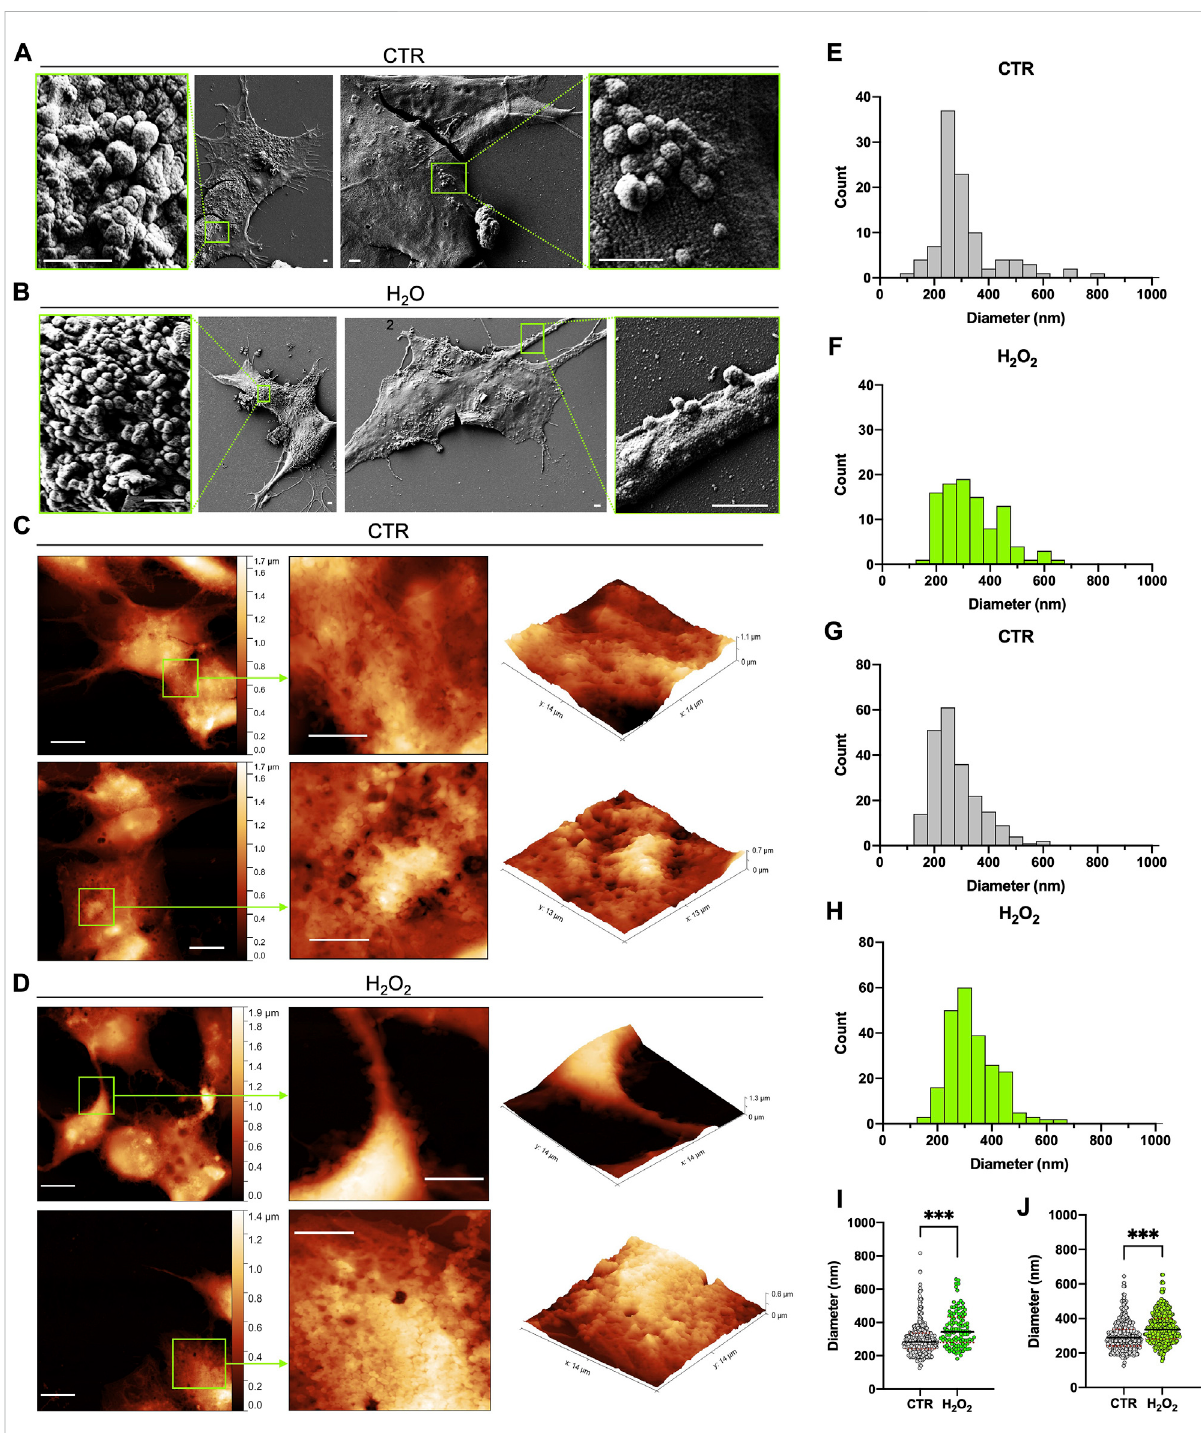
FIGURE 1 ComparisonbetweenSEMandAFMimagingofdriedcells. (A) and (B) 2typicalSEMimagesacquiredonthecontrolandH2O2treatedcells,respectively,that showthepresenceofbudsonthesurfaceofthecellsinlocalizedregions;foreachimageazoomononeoftheseregionsishighlightedinagreenbox(scalebar 1 µm). (C) and (D) 2typicalAFMimagesacquiredonthecontrolandH2O2treatedcells,respectively,thatshowthepresenceofextensivebuddingonthesurfaceof thecells; for eachimage (left side, scale bar 10 µm) a zoom on a region of interest highlighted in green is reportedin2-D (centre, scale bar 6 µm) and 3-D (right) views in order to better visualize the spatial arrangement of the membrane. (E) to (H) statistical analysis performed on the size distribution of the vesicles measured from all the SEM (E,F) and AFM (G,H) images acquired on the control (E,G) and H2O2 (F,H) treated cells. (I) and (J) dot plots of the direct comparison betweentheparticledistributionofbudsobtainedoncontrol(grey)versusH2O2treated(green)cellsfromSEM[ (I) ,mediandiameterof284±5 nmforthecontrol cellsand343±10 nmfortheH2O2-treatedones]andAFM[ (J) ,mediandiameterof289±4 nmforthecontrolcellsand337±4 nmfortheH2O2treatedones] images. For both techniques the obtained distributions are statistically different ( p <